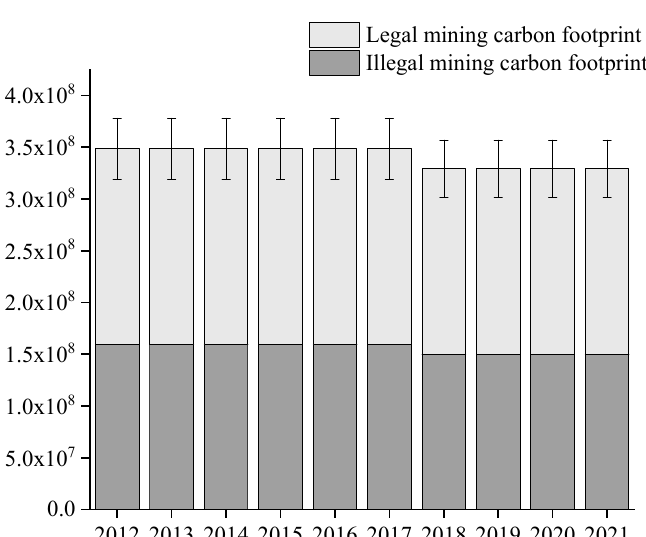
Figure 3. Carbon footprint of ion-type rare earth development from 2012 to 2021. 3.3. Effect of Material Transport Distance on Carbon Footprint of Ionic Rare Earth Development